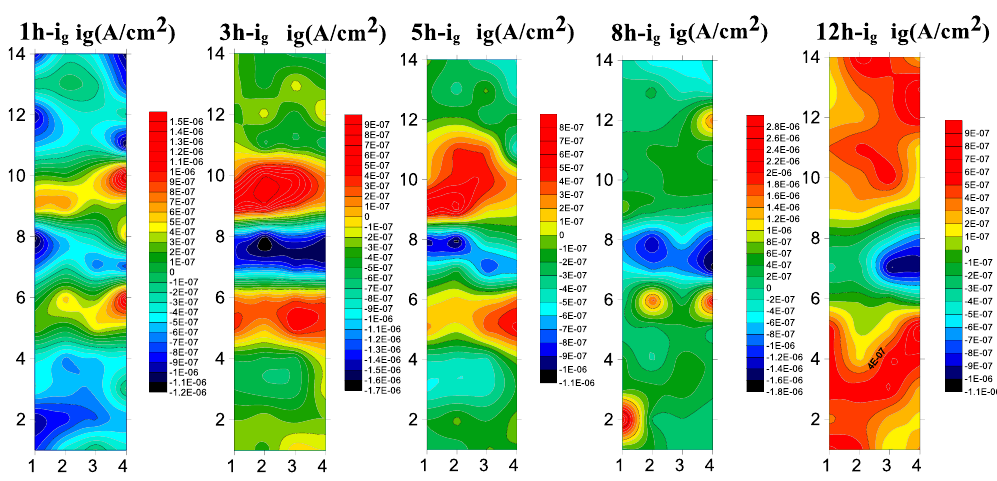
Figure 16. Array electrode test results of B10 alloy welded joint area at 3